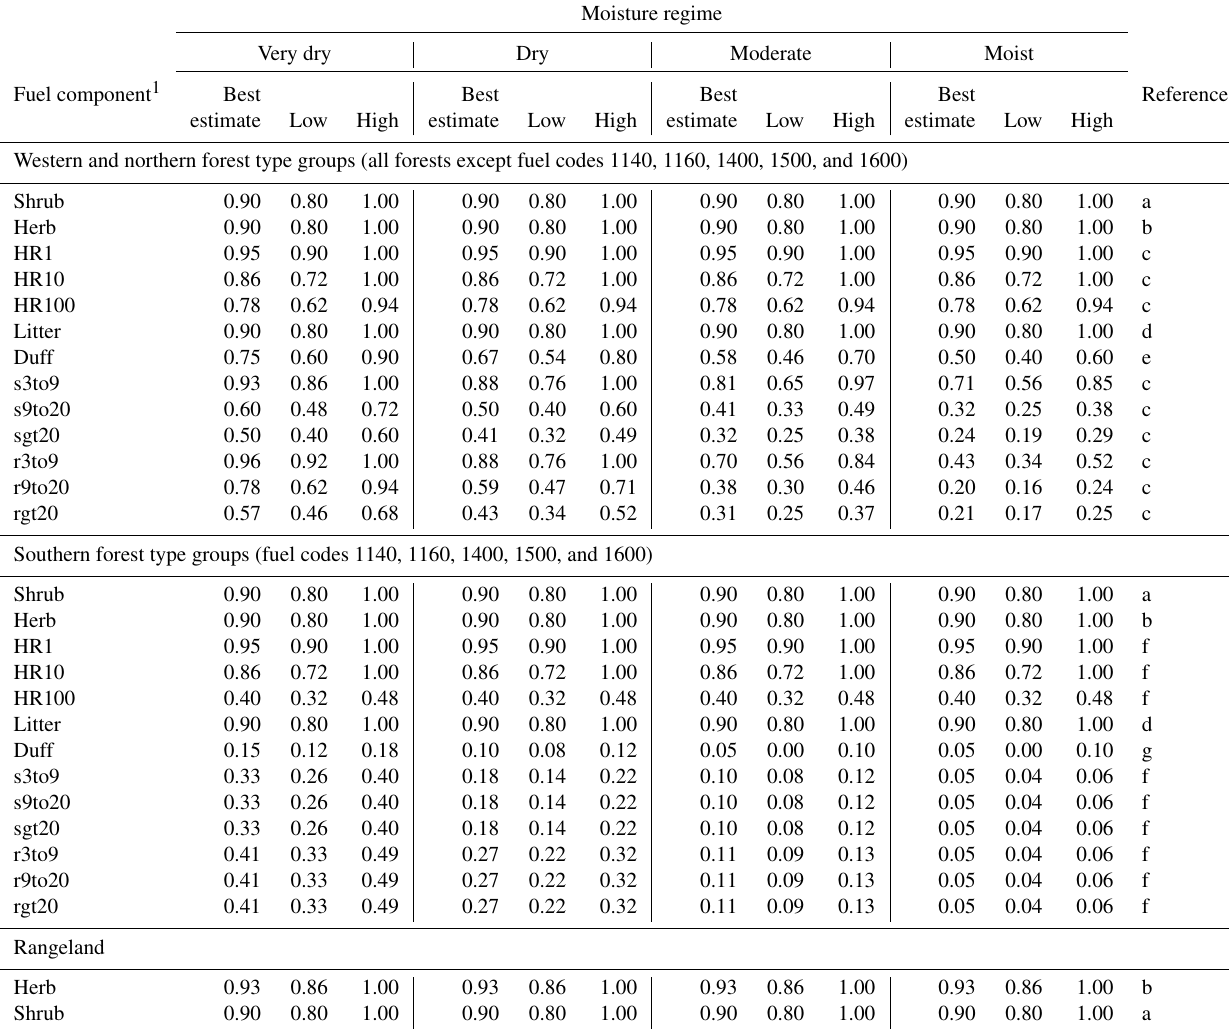
1 See Table 3 for description. References: (a) CONSUME natural fuel algorithm shrub stratum, adjusted to 0.90 (Prichard et al., 2006); (b) CONSUME natural fuel algorithm non-woody stratum, adjusted to 0.90 (Prichard et al., 2006); (c) CONSUME natural fuel algorithm – western woody equations (Prichard et al., 2006); (d) FOFEM default reduced to 0.90 (Lutes, 2016a); (e) Eq. (10) of Brown et al. (1985); (f) CONSUME natural fuel algorithm – southern woody equations (Prichard et al., 2006); (g) Hough (1978); (h) CONSUME natural fuel algorithm non-woody stratum (Prichard et al., 2006).